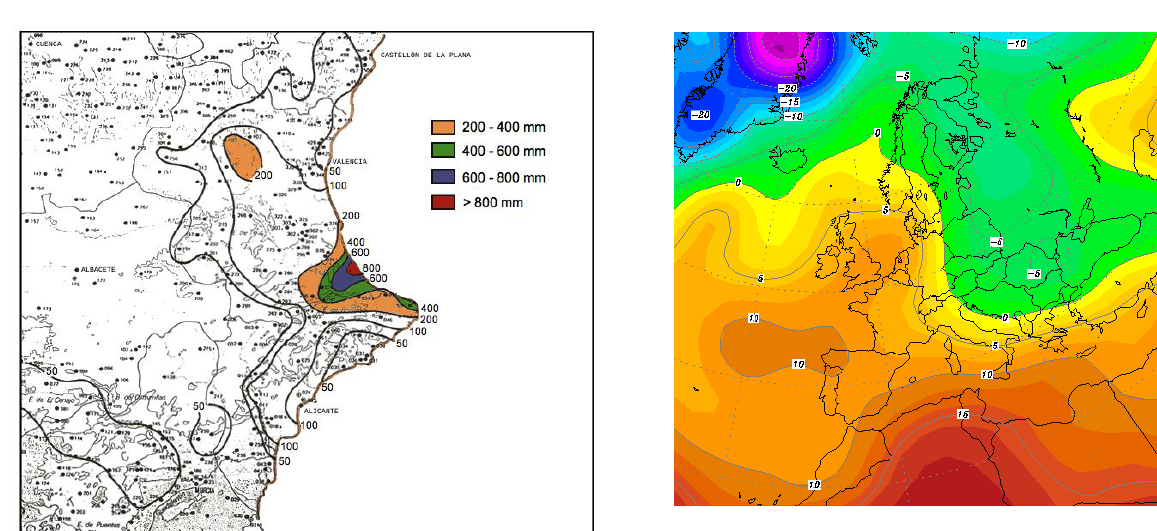
Figure 13.- NCEP reanalysis for 4th November 1987 at 00 UTC. Colors indicate temperature at 850 hPa according the Fig. 13. NCEP reanalysis for 4 November 1987 at 00:00UTC. Col- scale. ors indicate temperature at 850hPa according to the Figure 11.- Spatial distribution of rainfall for 3rd November 1987. Colors highlight the areas with the most intense Fig. 11. Spatial distribution of rainfall for 3 November 1987. Col- precipitation amounts according the scale. (from Riosalido et al. 1988) ors highlight the areas with the most intense precipitation amounts according to the scale (from Riosalido et al., 1988).